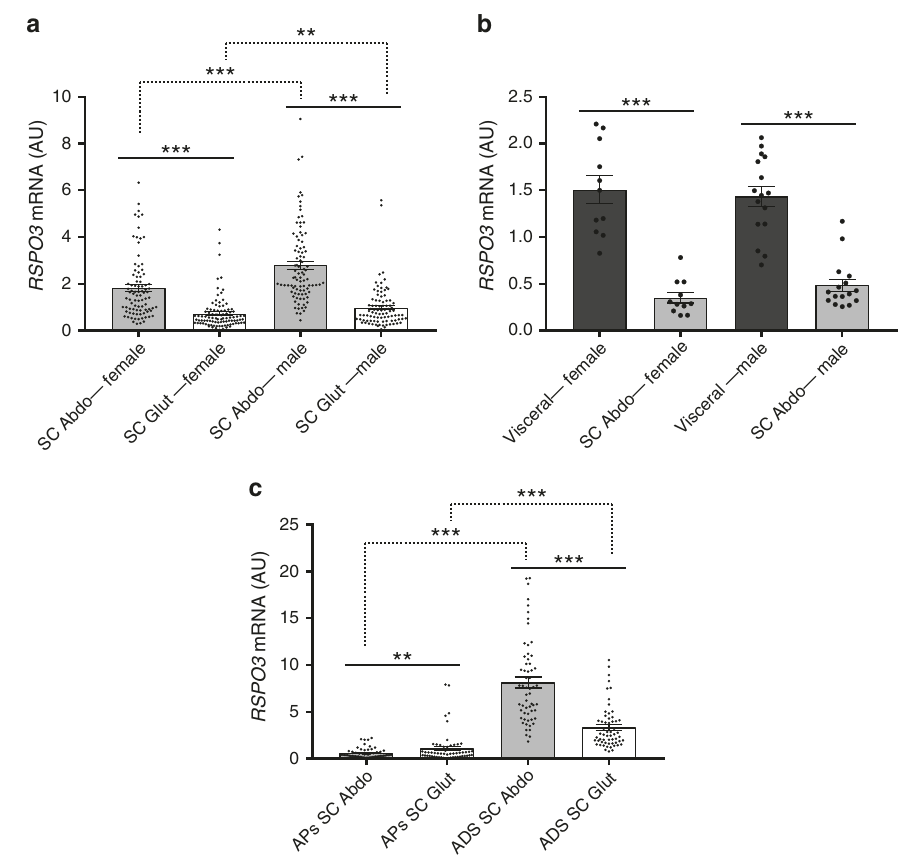
Fig. 2 RSPO3 expression in human abdominal and gluteal whole AT and AT fractions. Normalised RSPO3 mRNA levels in: a paired SC abdominal (Abdo) versus gluteal (Glut) fat biopsies from healthy women ( n = 103) and men ( n = 97), b paired visceral versus SC abdominal AT from 11 women and 16 men, and c fractionated AT [cultured APs and isolated mature adipocytes (ADS)] from 59 women. Histogram data are means ± s.e.m. ** p < 0.01, *** p < 0.001, statistical signi fi cance was assessed by univariate analyses adjusted for age and BMI, and with Bonferroni correction for multiple testing for a , and by two- tailed paired Student ’ s t -tests for b and c . Source data are provided as a Source Data fi le.